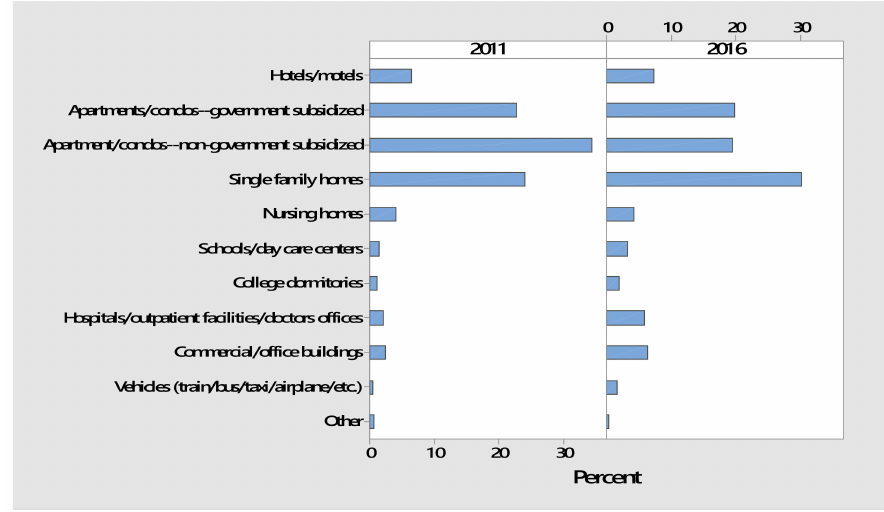
Figure 5. Percentages of bed bug treatment sites in 2011 and 2016.